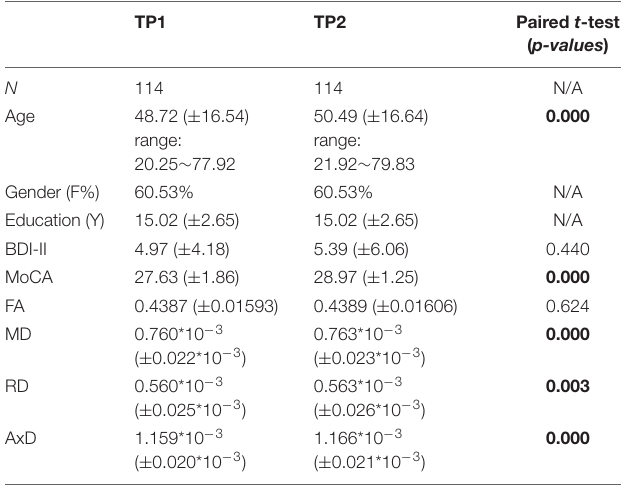
TABLE 1 | Participants’ demographic information and DTI measures for time point 1 (TP1) and time point 2 (TP2) and their corresponding paired t -tests. TP1